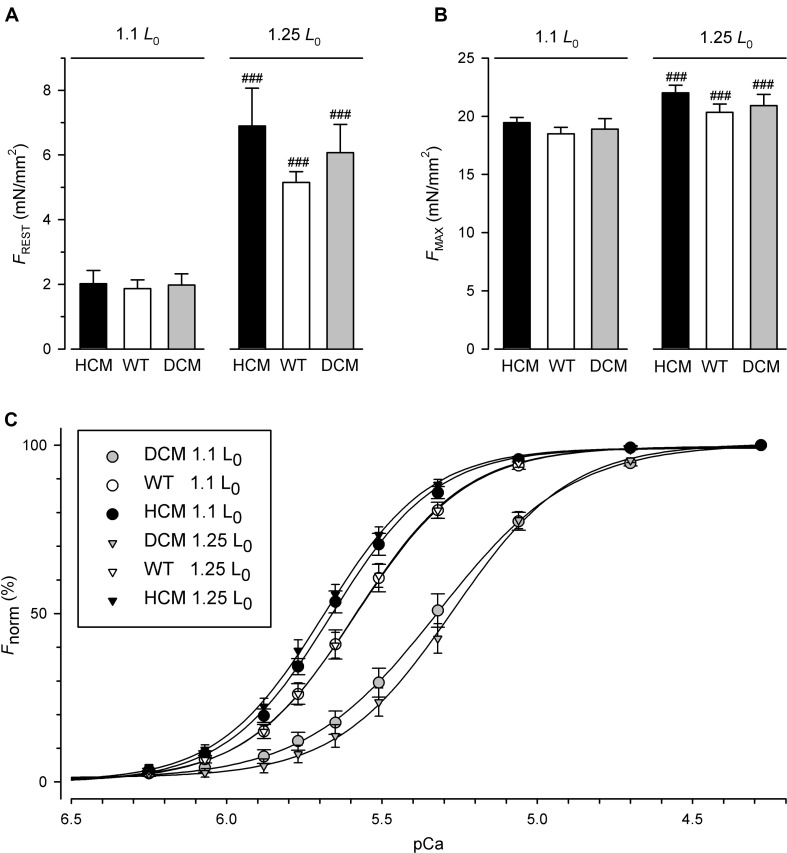
Resting, maximum and calcium-dependent force generation of skinned fibers exchanged for human hcTn containing HCM-associated hcTnTR130C (n = 18 fibers), hcTnTWT (n = 19 fibers), or DCM-associated hcTnTΔK210 (n = 19 fibers). (A) Resting tension measured in relaxing solution (pCa 7) at short (1.1 L0) and long (1.25 L0) fiber length. (B) Maximum tension measured at pCa 4.28. (C) Force-pCa relations at short fiber length (1.1 L0) and long fiber length (1.25 L0). Normalized force is scaled as percentage from 0% for resting tension to 100% for maximum tension. ###Indicates highly significant different to 1.1 L0 in paired Bonferroni post tests.